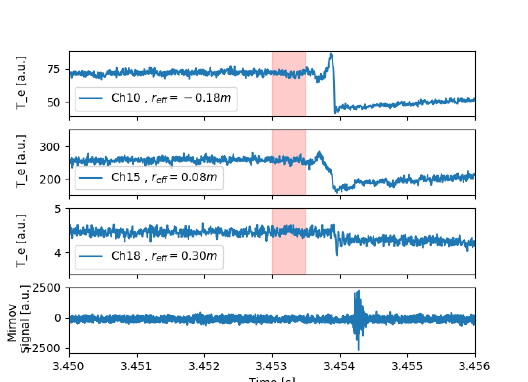
Figure 5 : Three ECE channels and Mirnov coil signal related to a typical crash of Figure 7. Main features are different with respect to Figure 4, especially with respect to precursor activity (comparing red boxes in this figure and Figure 5, it is possible to notice that the strength of precursor activity is